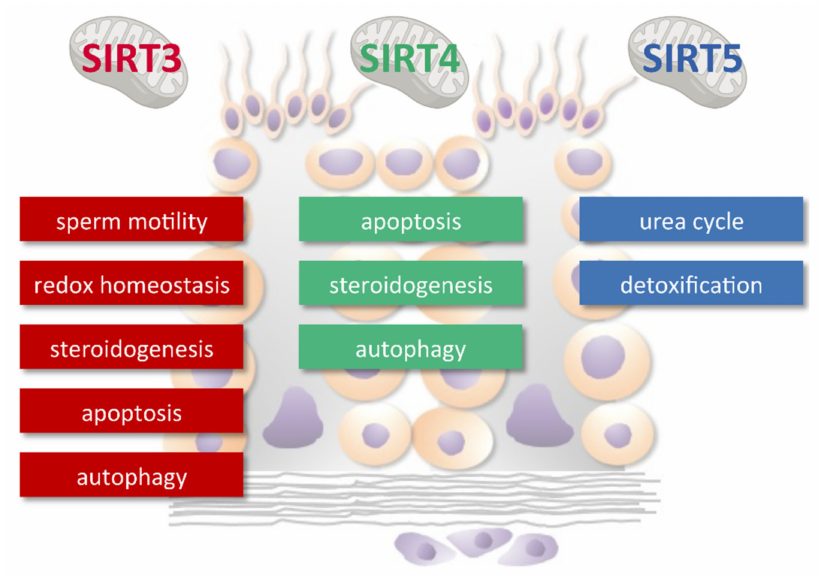
Figure 6. Main functions of mtSIRTs in spermatogenesis and male reproduction. MtSIRTs participate in homeostasis maintenance under stress